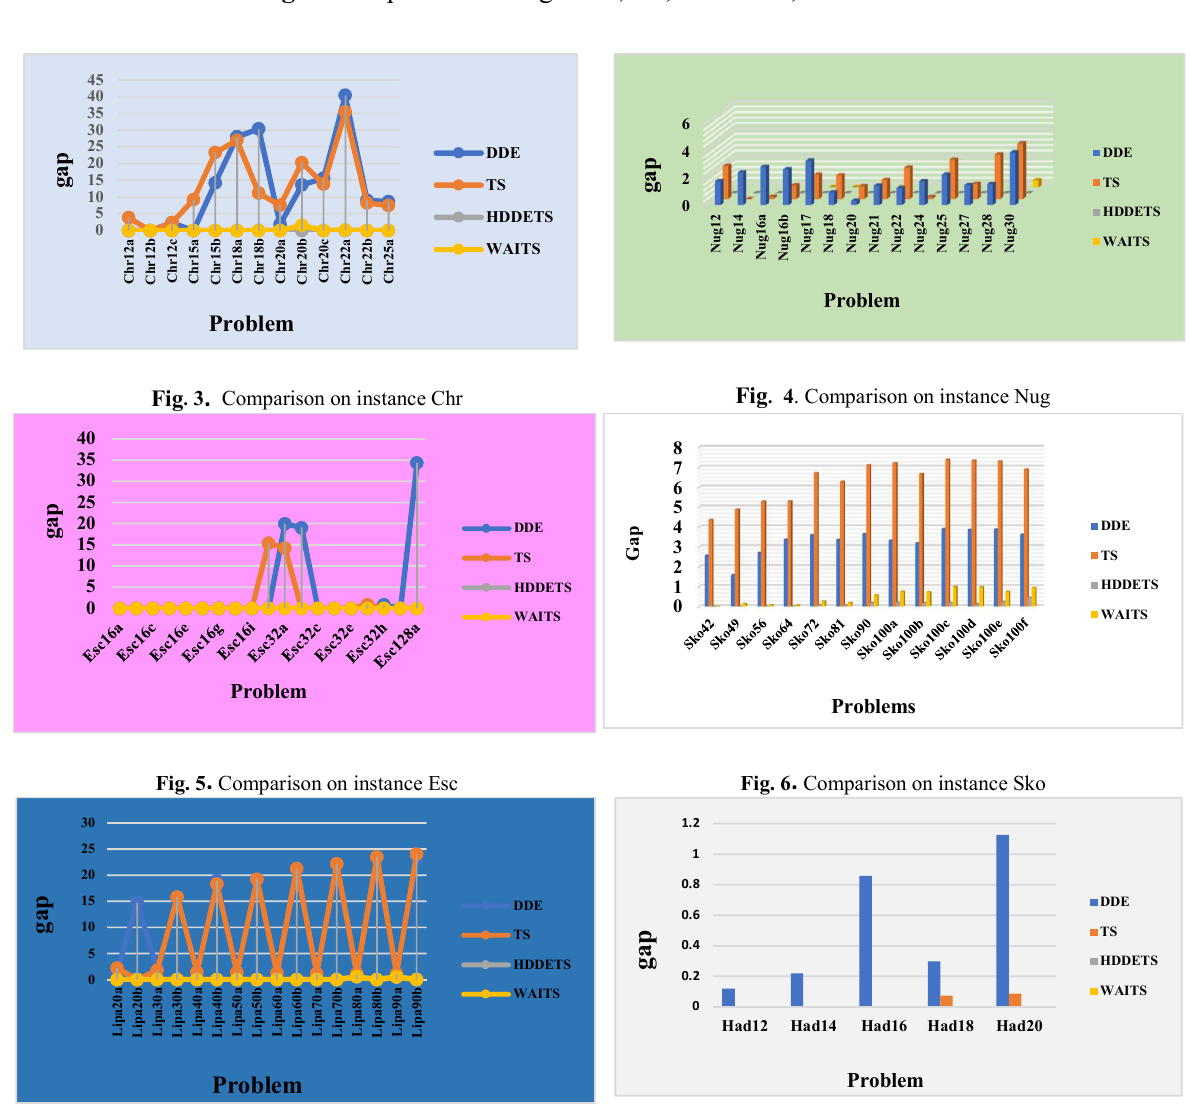
Fig. 7 . Comparison on instance Lipa Fig. 8 . Comparison on instance